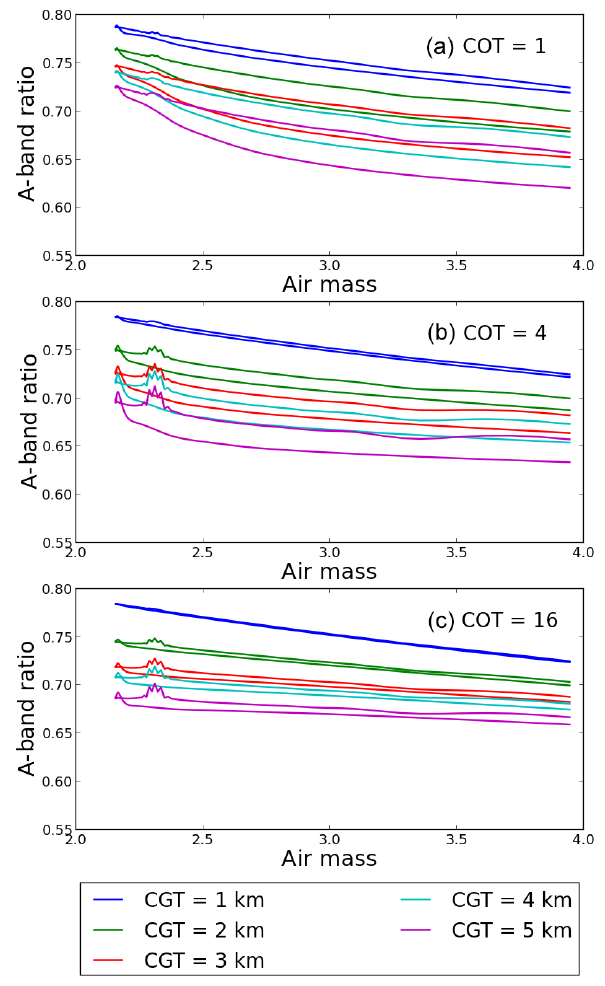
Figure 5. Effect of cloud geometrical thickness variation CGT on the band ratio. SZA = 30 ◦ , VAA = 0 ◦ , CTOP = 6km, (a) COT = 1, (b) COT = 4, (c) COT =